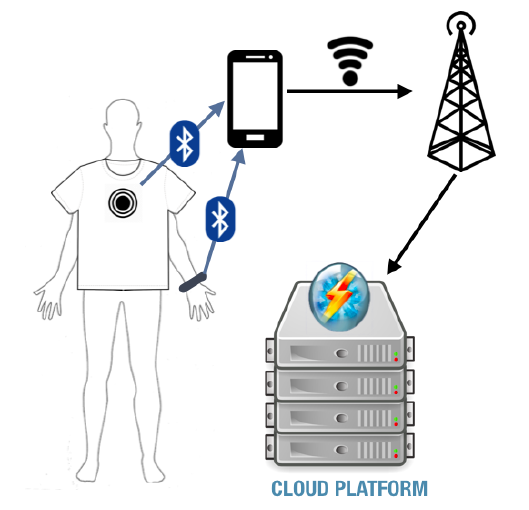
Figure 4. The system architecture of iSleePost, consisting of two wearable accelerometer sensors with BLE chip, a smartphone, and a personal computer connected to the